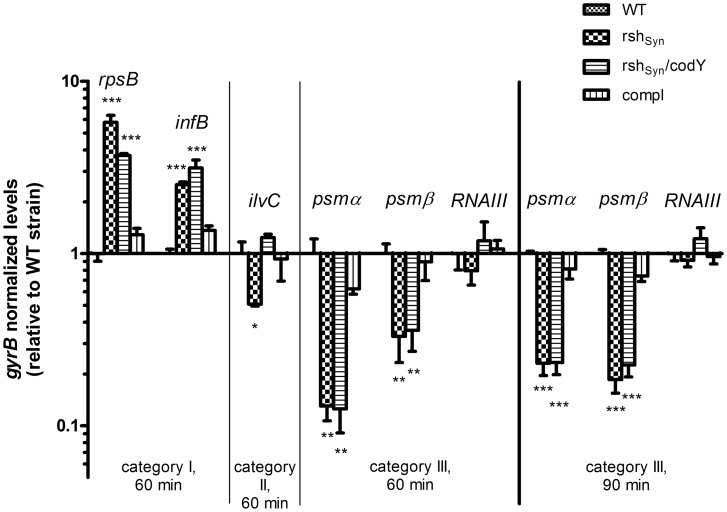
Quantitative RT-PCRs of phagocytosed bacteria.Transcript analyses of rpsB, infB (category I), ilvC (category II), psmα1-4, psmβ1,2 (category III) and RNAIII genes after phagocytosis of the S. aureus strain HG001 and the corresponding rshSyn mutant, rshSyn, codY double mutant and the complemented rshSyn mutant (compl). The transcripts were relatively quantified in reference of gyrB and are shown in a log10 scale relative to the wild-type strain (HG001). RNA was isolated after a 60 and 90-minute interaction of S. aureus with PMNs. Values from four separate experiments were used to calculate the mean expression. The levels of significance compared to the wild-type strain were determined by the two-tailed Student t test (p<0.05).